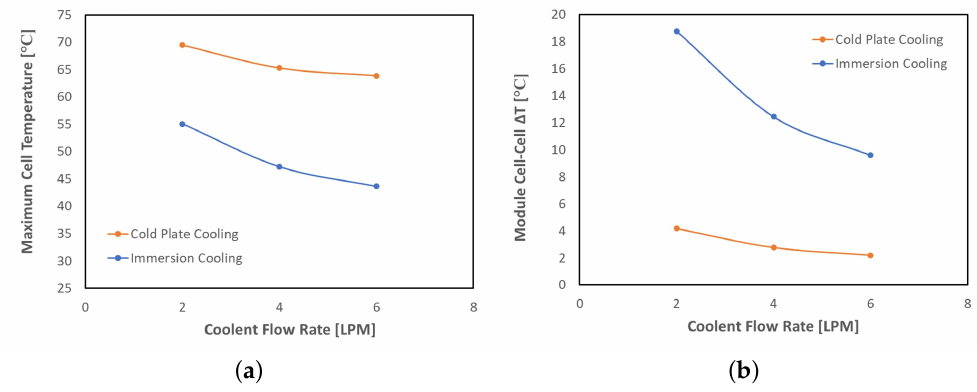
Figure 13. Effect of variation of coolant flow rate on ( a ) maximum cell temperature (°C), and ( b ) cell-to-cell temperature differential within the immersion-cooled and cold-plate-cooled modules